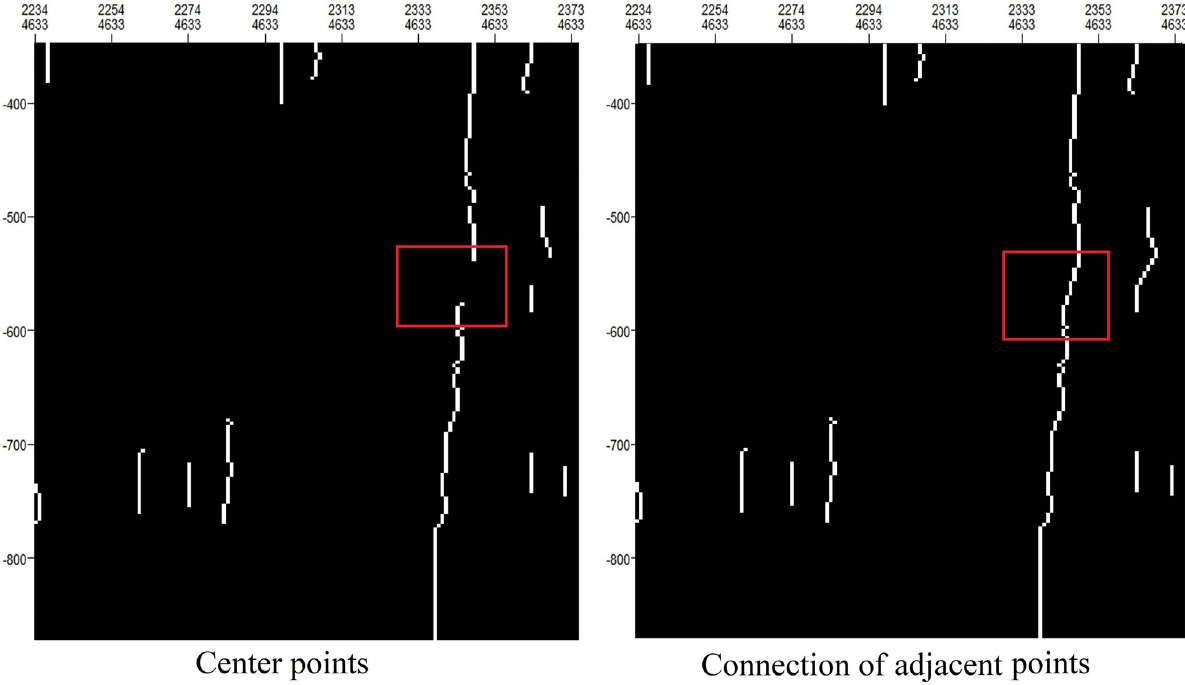
point between P and P in each row. i stands for row i , j stands for column j . P ( i , j ) repre- 1 2 1 1 sents the starting point of the white area in row i , and P ( i , j ) represents the end point of 2 2 the white area in row i . Round indicates mathematical rounding. ( i , round ( j )/2) indi- 2 − j 1 cates the coordinates of the center point ( P ) of the i row (red 255 in Fig 5). 3 Connection of adjacent points. To extract a fault line, its corresponding center points must be connected. In accordance with the principle of eight-neighborhood connectivity, some adjacent points can be regarded as line segments. By traversing all line segments, we can determine whether the distance between one of the two endpoints of a line segment and an endpoint of another line segment is less than D. If so, we connect those two endpoints. Fig 6 shows the fault line obtained with D = 15 for the considered example. Removal of short lines. The skeleton extraction method described above may produce anomalies. For example, discontinuities in seismic waves caused by lateral nonstructural fac- tors will also be reflected as longitudinal fault lines. Therefore, excessively short line segments need to be removed. We remove the current line segment when its length is shorter than a cer- tain threshold length. The image after the connection of adjacent points in Fig 7 comes from Fig 6.